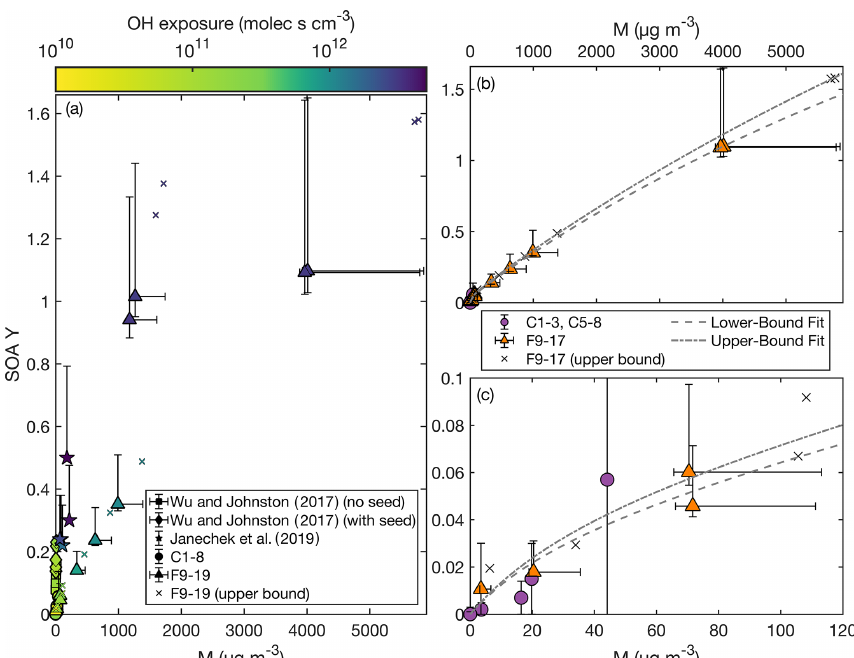
Figure 2. SOA yield as a function of organic aerosol mass concentration ( M ) as (a) compared to that reported by Wu and Johnston (2017) and Janechek et al. (2019). The color axis is the OH exposure. Panel (b) shows the SOA yield for experiments C1–3, C5–8, the non-wall- deposition-corrected F9–17, and the wall-deposition-corrected F9–17. Also included are the fits of a two-product absorption partitioning model to C1–3, C5–8, and the non-wall-deposition-corrected F9–17 (dashed curve) and to C1–3, C5–8, and the wall-deposition-corrected F9–17 (dashed and dotted curve). Panel (c) focuses on experiments with M < 120µgm − 3 .